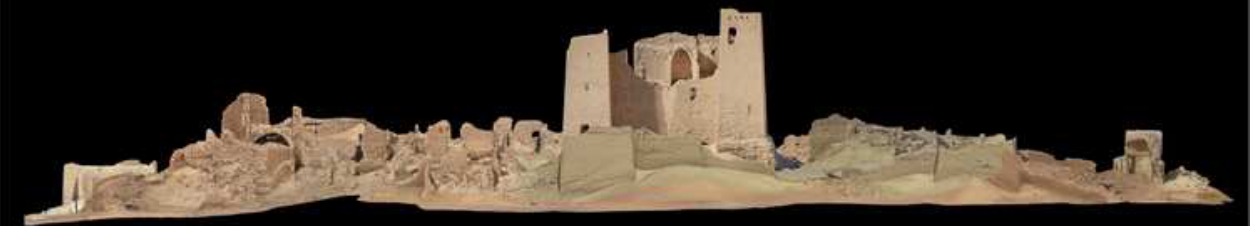
Figure 8. The south view of the settlement extracted from the high-resolution point cloud.